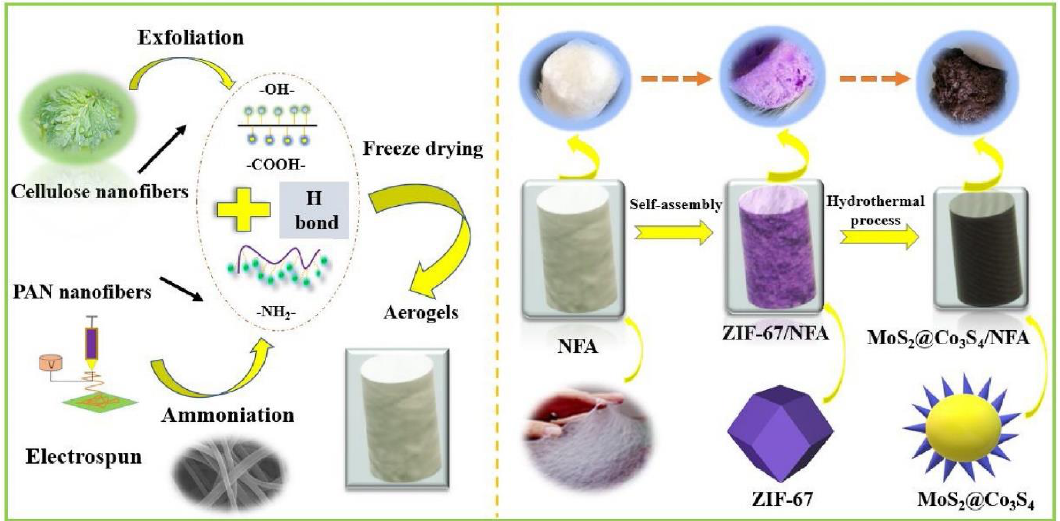
Figure 4. Three-dimensional fibrous aerogel assemblies made by vacuum freeze drying technology and their application for photocatalyst support. NFA means nanofiber aerogels. ZIF-67 stands for the zeolitic imidazolate framework-67, or 2-methylimidazole cobalt salt. Reprinted with permission from [12]. Copyright © 2019 Elsevier B.V.